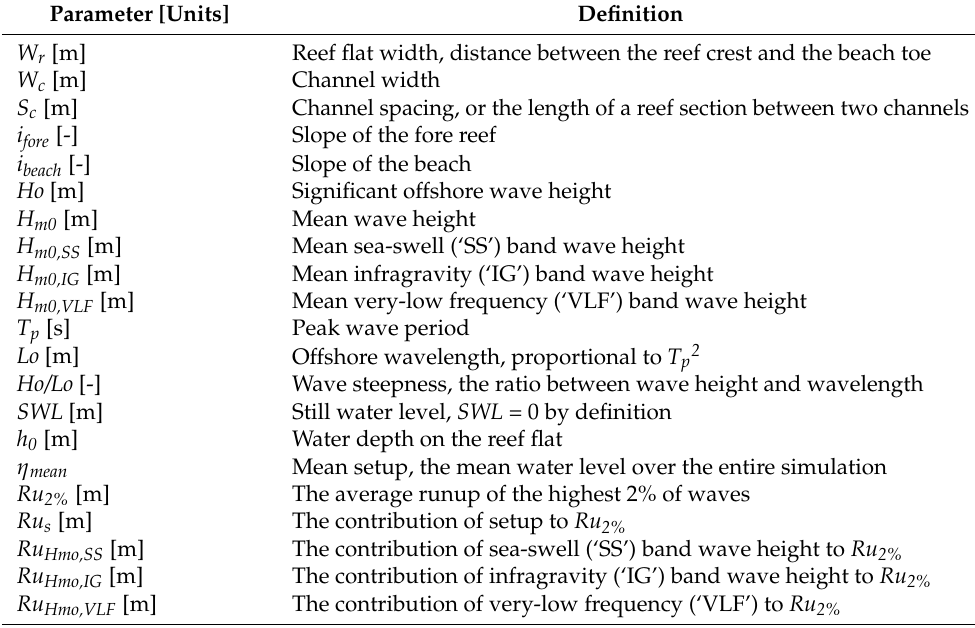
Table A1. Reef and channel geomorphic parameters and oceanographic forcing parameters used in this